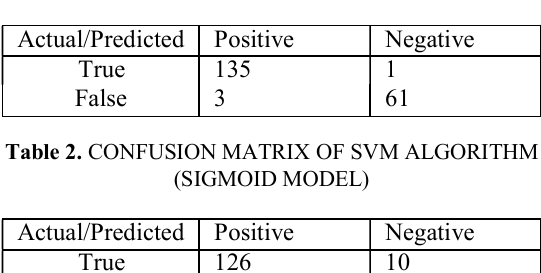
Table 1. CONFUSION MATRIX OF SVM ALGORITHM